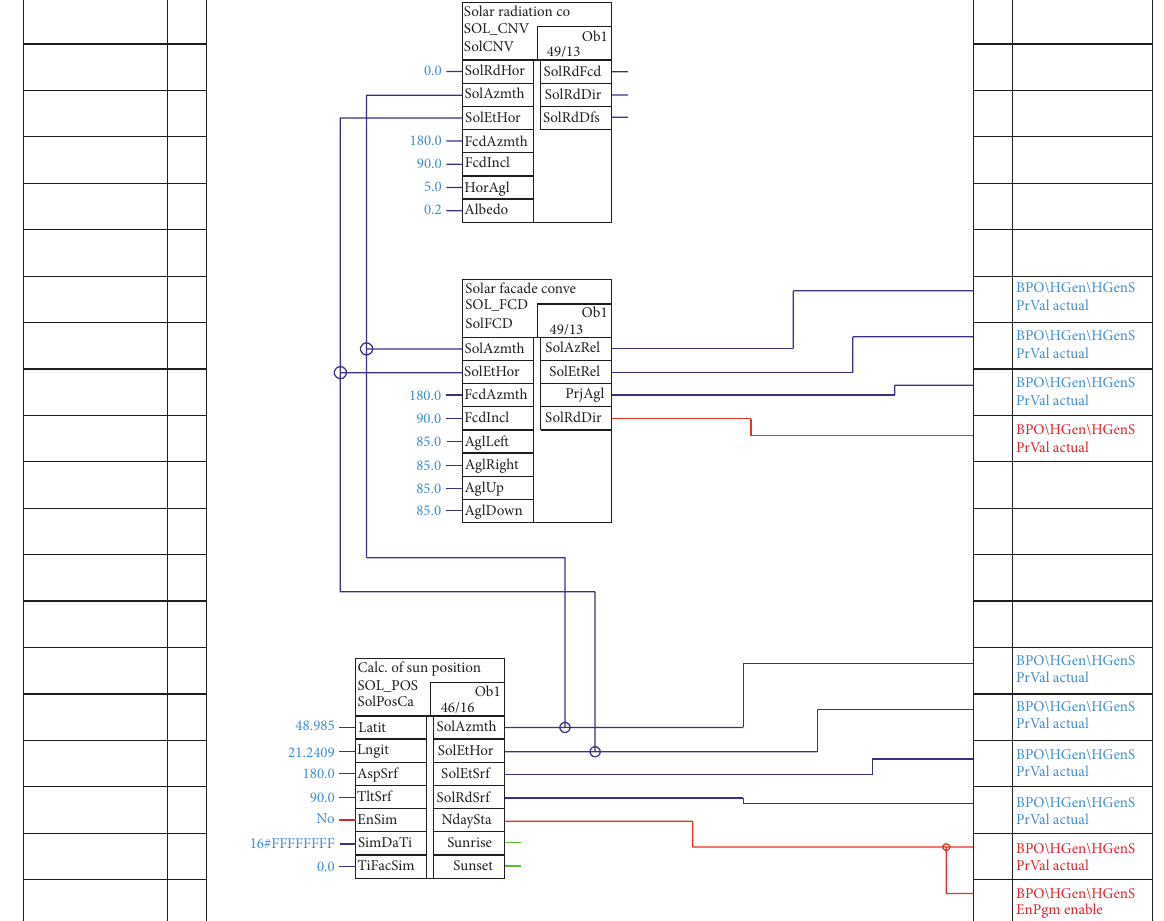
Figure 12: A block diagram of the Sun position